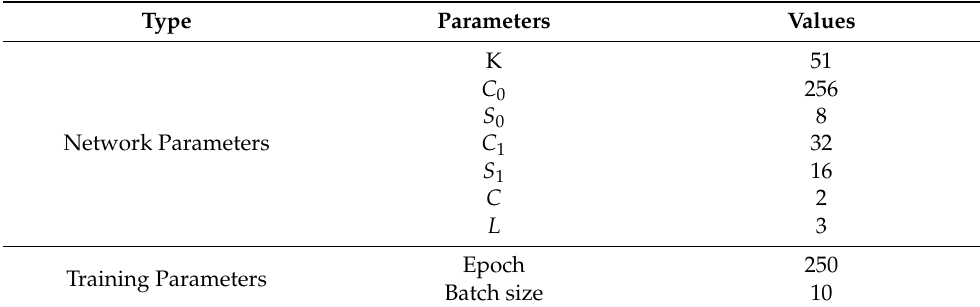
Table 1. Hyper-parameters of